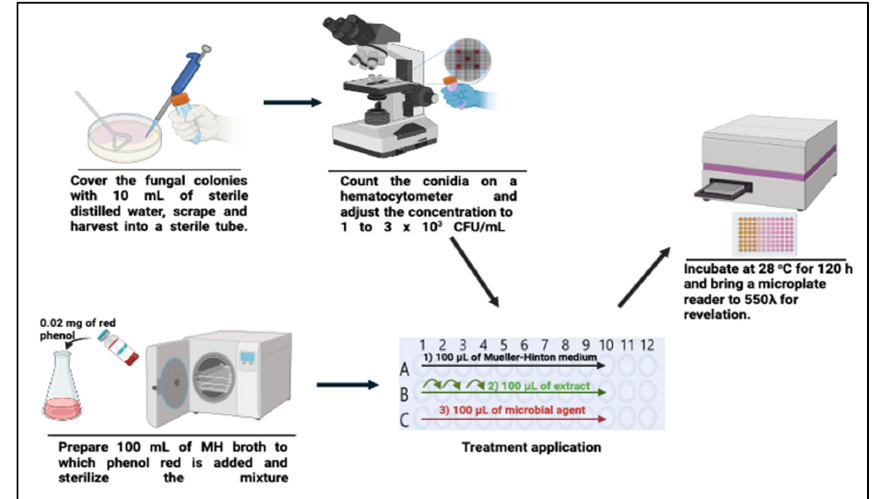
Figure 2. Flowchart to determine the antifungal